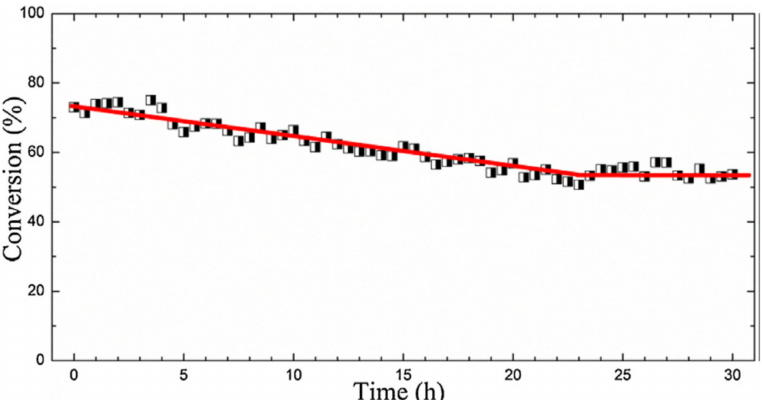
Figure 14. Stability test for the catalytic activity of the ternary oxide system (reproduced from Ref. [218]).